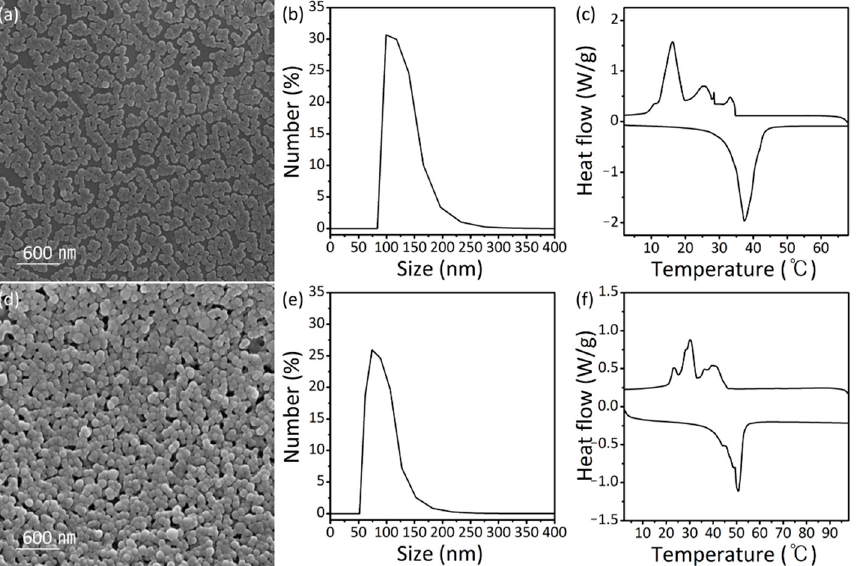
Figure 4. ( a ) SEM image, ( b ) DLS measurement, and ( c ) DSC curves of n-eicosane/PMMA nano- beads. ( d ) SEM image, ( e ) DLS measurement, and ( f ) DSC curves of n-tetracosane/PMMA nano- beads.